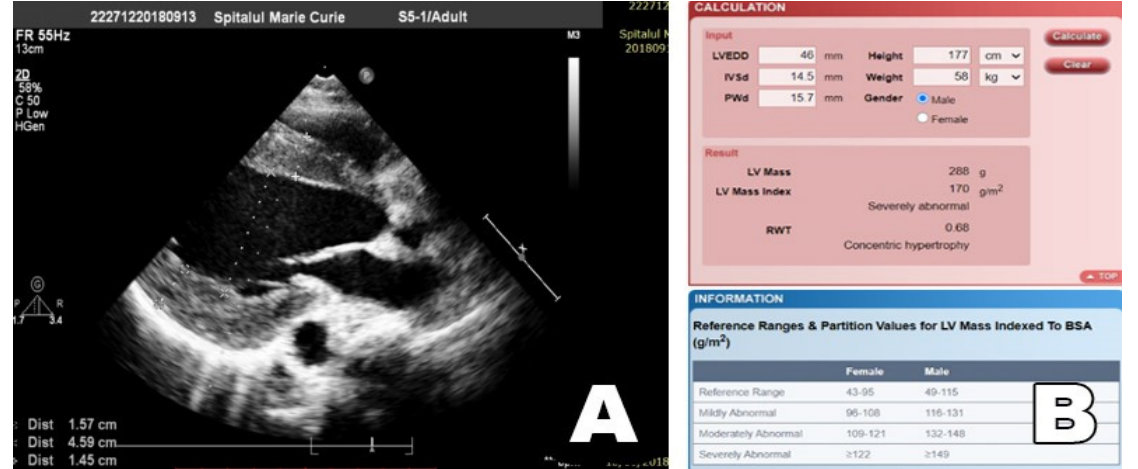
Figure 4. ( A ) Measurement of the LV wall thickness by 2D echocardiography, parasternal long-axis view (14-year-old patient from the study sample); ( B )—calculation of the LVMI for the same patient (LVMI = 170 g/m2—severe concentric LVH).